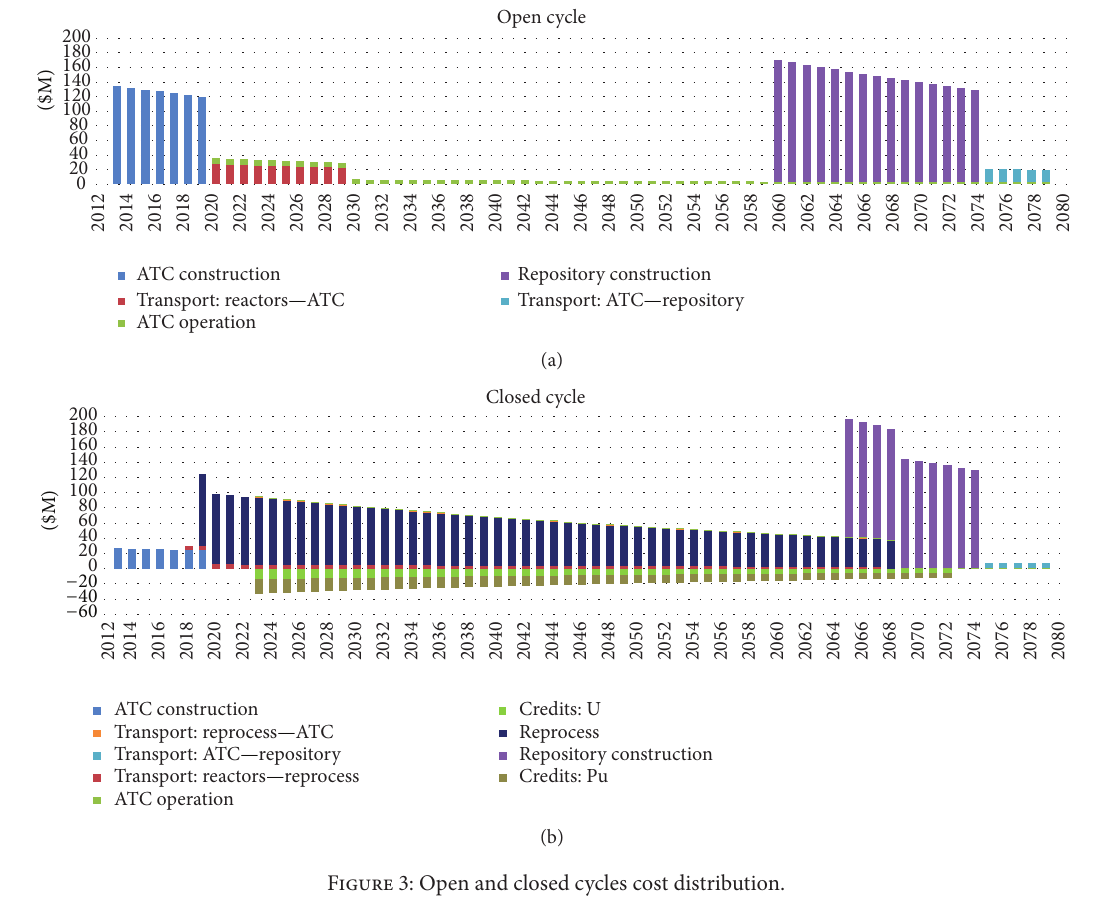
Figure 3: Open and closed cycles cost distribution.